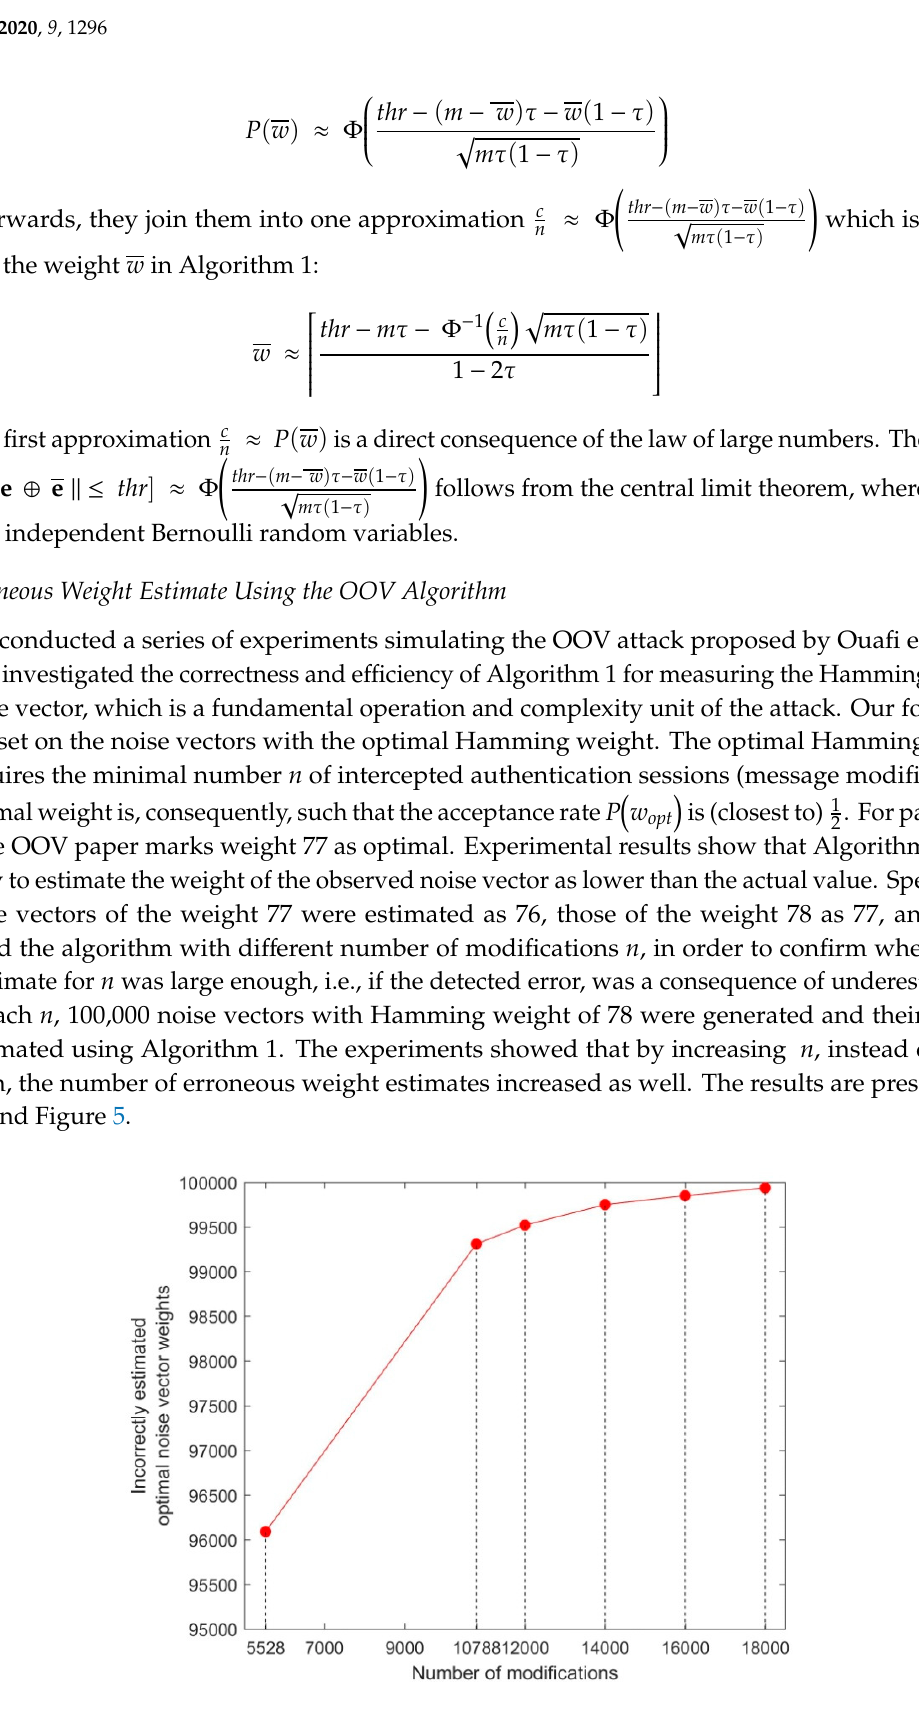
Figure 5. The increase in erroneous weight estimates with the increase of number of modifications. The observed sample consists of 100,000 noise vectors of the Hamming weight 78. Table 1. The ratio of correct weight estimates gets smaller as the number of modifications increases.